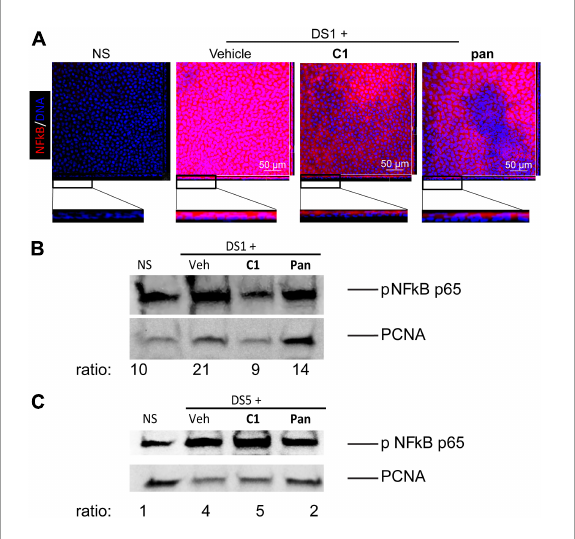
FIGURE2 Topical Treatment With C1 and pan Eye Drops Decrease Early Cornea NFkB Nuclear Translocation. Mice were subjected to desiccating stress for either 1 day (DS1) or 5 days (DS5). Whole corneas were used for whole-mount staining, while nuclear corneal epithelial lysates were used for western blot. (A) Merged images (en face) of laser confocal microscopy of whole-mount corneas stained with NFkB antibody (red) with DAPI nuclear staining (blue). Insets show images turned at 90 degrees to show individual cells. (B) Representative western blot in corneal epithelium lysates of DS1 mice that were blotted with anti-NFkB antibody, or PCNA as a loading control. Each sample contains nuclear proteins obtained from pooling 8 mice (16 corneas) per group. (C) Representative western blot in corneal epithelium lysates of DS5 mice that were blotted with anti-NFkB antibody, or PCNA as a loading control. Each sample contains nuclear proteins obtained from pooling 8 mice (16 corneas) per group.